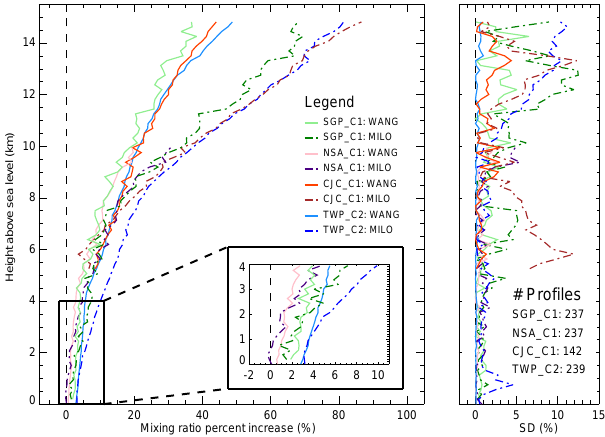
Figure 2. The mean relative increase in the water vapor mixing ra- tio caused by the two correction algorithms for RS92 radiosondes launched at the SGP, NSA, TWP, and CJC sites (left) and the stan- dard deviation (right) as a function of height. The MILO (WANG)- corrected data are shown with dotted (solid) lines. The number of comparisons for each site is shown in the figure. NSA results are only shown up to the mean tropopause height (10km). The inset plot on the main figure is the mean relative increase in the water va- por mixing ratio caused by the two correction algorithms, but only from 0 to